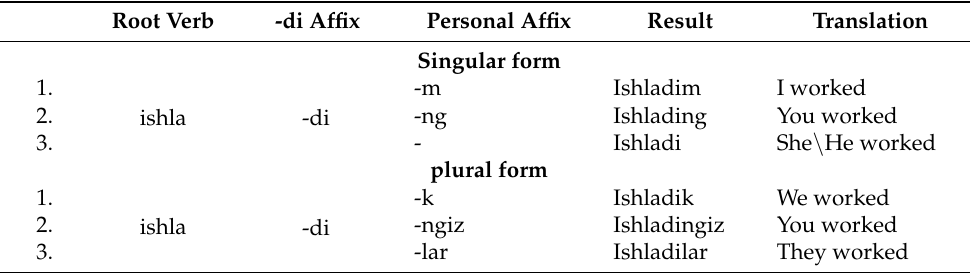
Table 8. Example of grammar rules of verb construction in present continuous tense. Root Verb -di